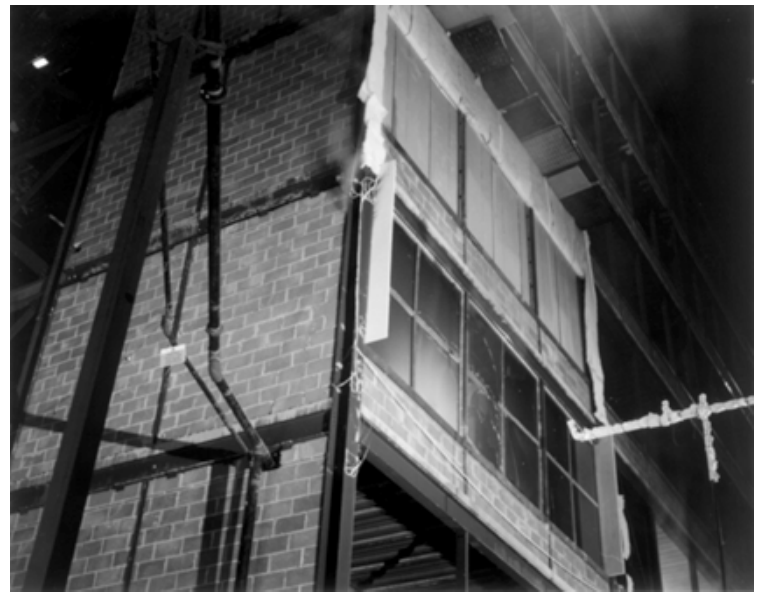
Fig. 6. Corner room fire test in steel building at